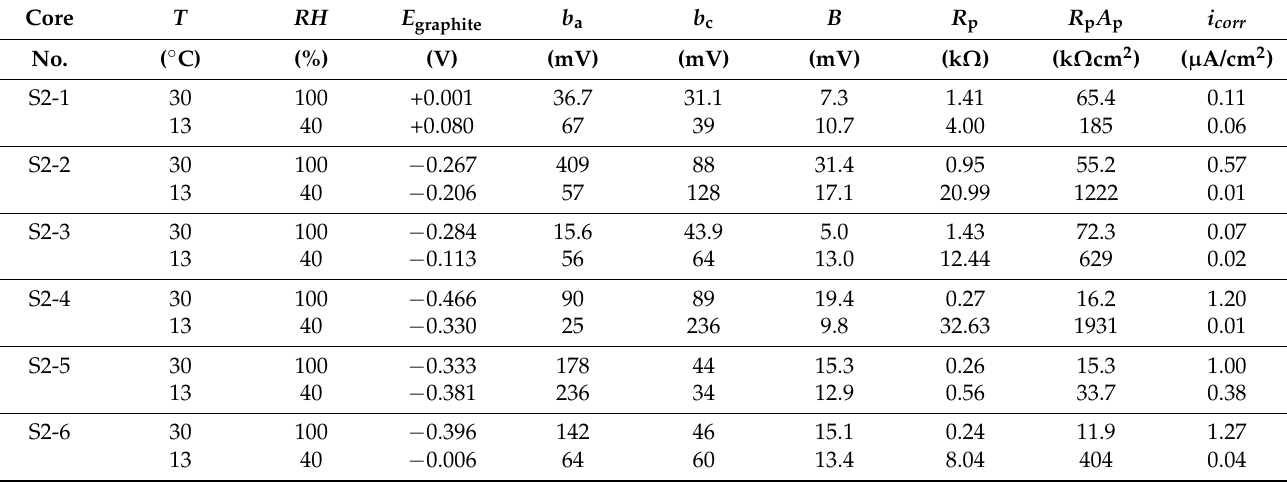
Table A4. Results of the analysis of polarization curves for steel reinforcement in cores drilled from the silo